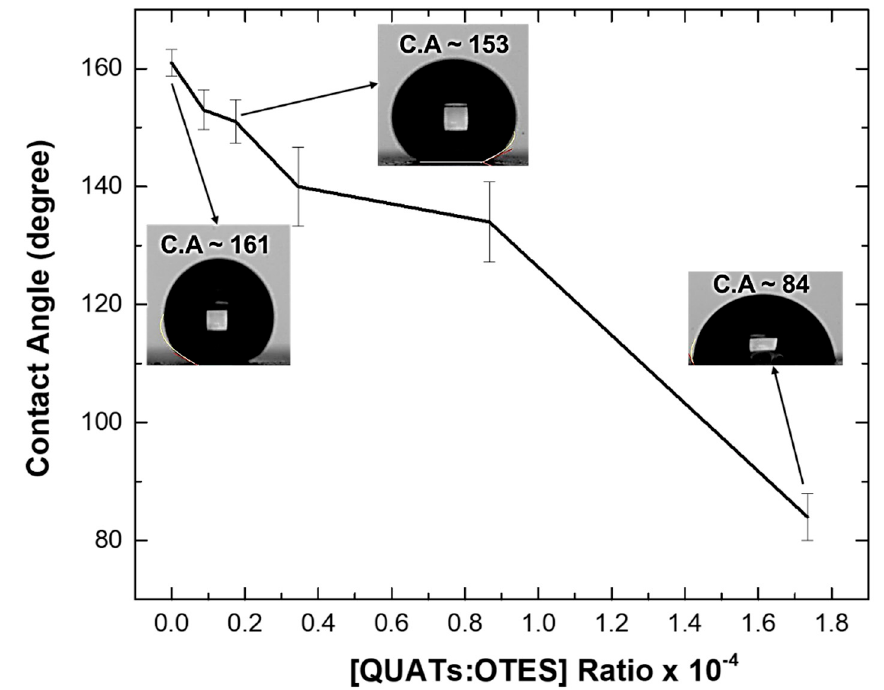
Figure 3. Variation in contact angle as a function of QUATs/OTES molar ratio.